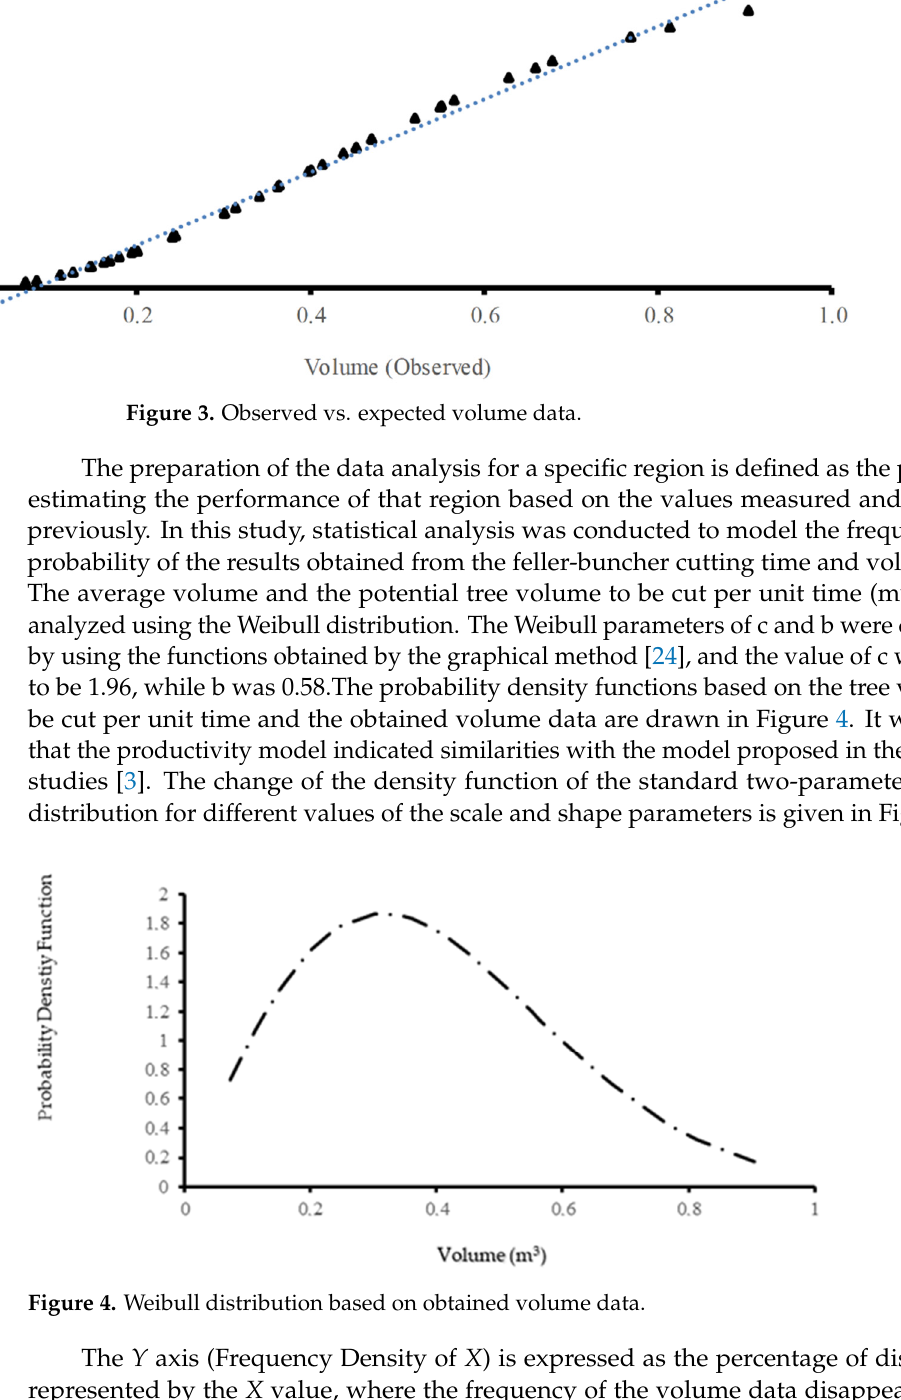
Figure 5. Illustrating the effect of a changing shape parameter (c) on the overall shape of the distribution. The Y axis (Frequency Density of X ) is expressed as the percentage of distribution represented by the X value, where the frequency of the volume data disappears from 0 as the Weibull distribution’s shape parameter increases. Thus, it turns out that the shape parameter gives preliminary information about the distribution of the volume frequency. Stout et al. [25] used six Victorian rivers to test the fit of the Weibull distribution, showing that the Weibull is a useful and flexible distribution that provides common reporting met- rics useful for future studies. In this study, the scale parameter of the distribution reflects the arithmetic mean of the volume, while the shape parameter is closely related to the productivity of the feller-buncher. 4. Conclusions Although there are various distribution functions that can be used in determining the distribution of machine processing time and harvested volume, the performance of the Weibull distribution method evaluated in this study provided promising results. The out- comes indicated that the volume (frequency) distribution observed in parallel with the findings obtained in this study can be represented by a two-parameter probability density